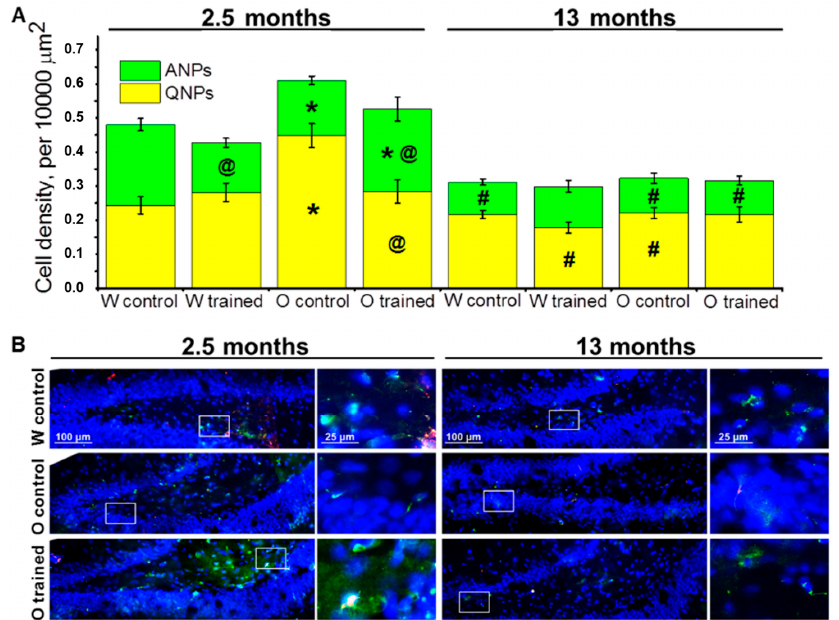
Figure 2. Neuronal progenitors’ density in the dentate gyrus (DG) of OXYS and Wistar rats. ( A ) The density of quiescent neural progenitors (QNPs) was higher in 2.5-month-old OXYS rats than in Wistar rats, and training in the MWM decreased this parameter in OXYS rats to the level of Wistar rats. The density of ANPs at 2.5 months of age was lower in OXYS rats compared to Wistar rats, and the training in the MWM lowered the parameter in young Wistar rats but increased it in young OXYS rats. The data are presented as mean ± SEM, n = 3 to 6. * p < 0.05 for differences between the strains; # p < 0.05 for a comparison with the previous age; @ p < 0.05 for effects of the MWM training. W: Wistar rats; O: OXYS rats. ( B ) Photomicrographs of the DG of control Wistar and OXYS rats, as well as trained OXYS rats at ages 2.5 and 13 months are shown as representative images of immunohistochemical staining with antibodies against nestin (green) and vimentin (red). DAPI (blue) highlights cell nuclei.